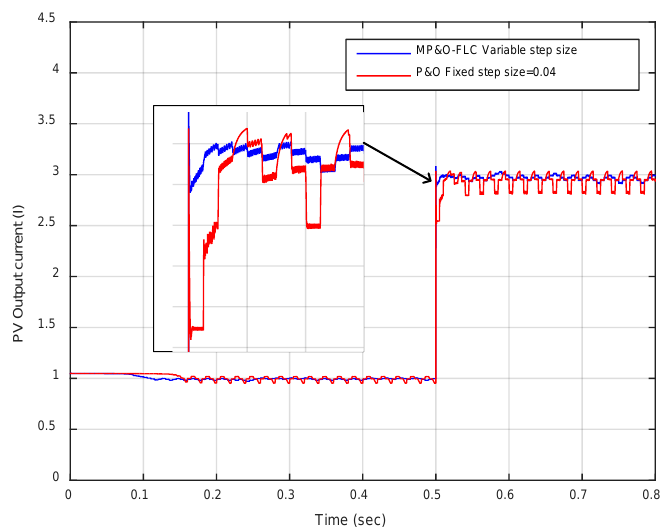
Figure 8. Comparison of PV current with fixed step size P&O MPPT and the proposed FLC-based variable step size P&O MPPT with a step change in solar irradiance.